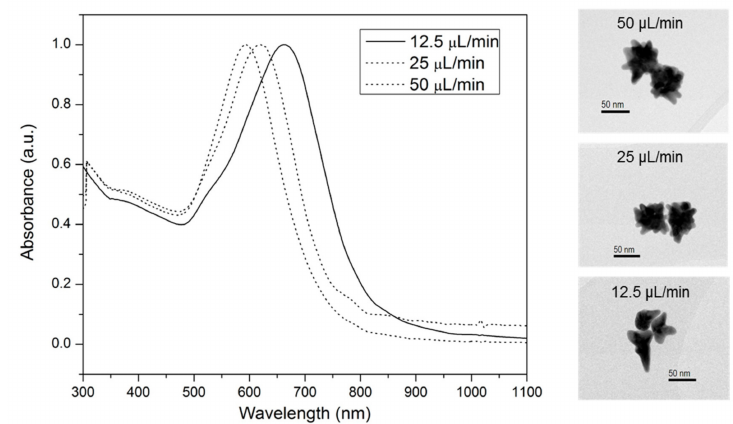
Figure 1. UV-Vis absorption spectroscopy of nanostars using di ff erent flow rates for the gold salt. Note the shift to the near infrared region (NIR) region with lower flow rates. TEM images of the nanostars that were generated with flow rates of 50 µ L / min, 25 µ L / min and 12.5 µ L / min (from top to bottom). These images suggest that the amount and length of spikes change with di ff erent flow rates. The diameter of the nanostars did not significantly change as confirmed by dynamic light scattering (DLS) where no significant increase was noticed with lower flow rates (50 µ L / min: 66.0 ± 1.5 nm; 25 µ L / min: 67.5 ± 2.7 nm: 12.5 µ L / min: 66.3 ± 7.8 nm; data not